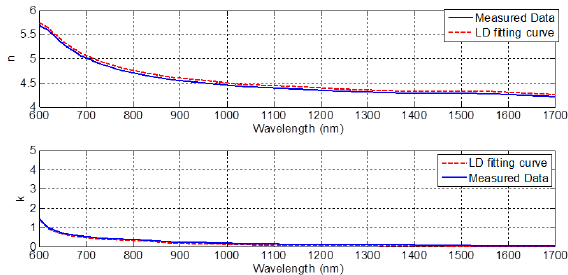
Figure 11. Experimental [11] and fitted Lorentz-Drude model for the real and imaginary parts of the Germanium refractive index in the second sub-band